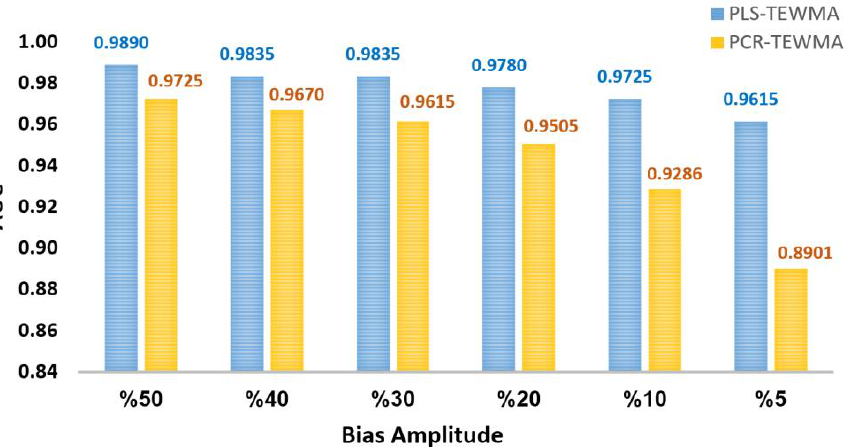
Figure 18. AUC values by PLS- and PCR-based TEWMA charts for different bias magnitudes in the pyranometer.